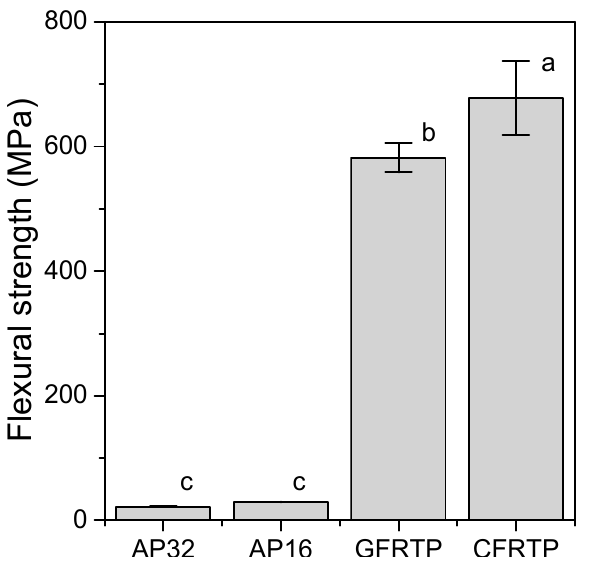
Figure 1. Flexural strengths of AP32, AP16, GFRTP, and CFRTP. Bars labeled with the same letter show no significant difference ( p > 0.05).